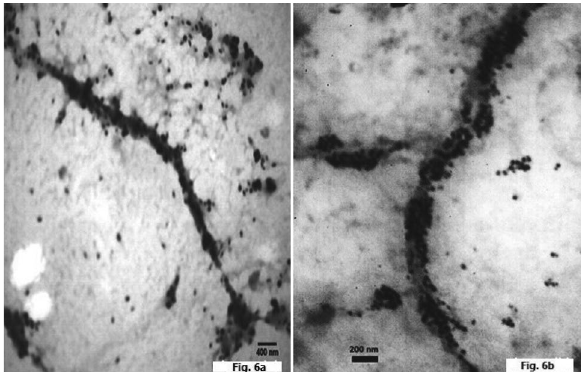
Figure 6. Transmission electron microscopy of plasmonic gold nano particle arrays on lysozyme amyloid fibrils, with pristine (a) and PSS-modified (b) plasmonic